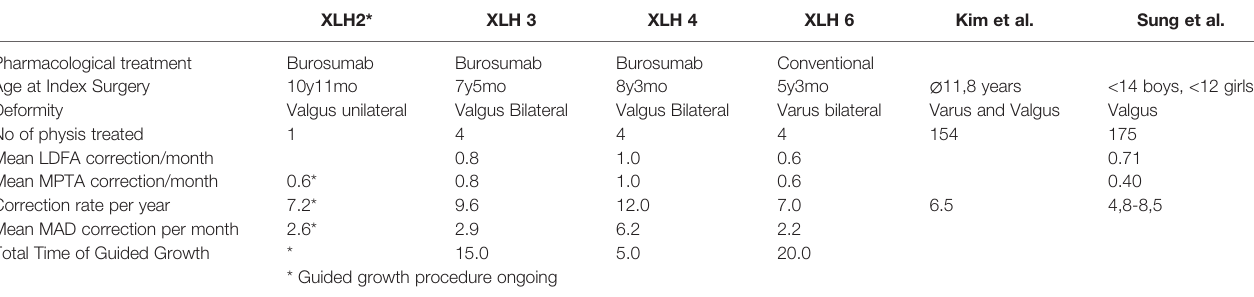
TABLE 1 | Guided growth correction